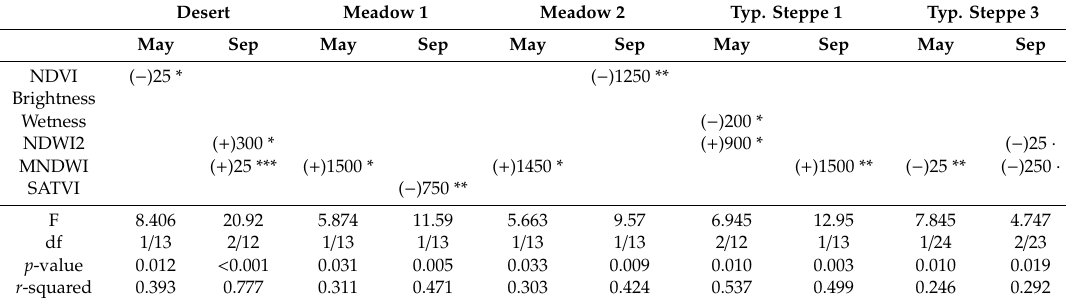
Table 3. Multiple linear regression models of carabid abundances with multispectral indices after excluding vegetation indices with collinearity problem and a stepwise procedure to select the best model on the remaining vegetation indices (NDVI, tasseled-cap brightness, tasseled-cap wetness, NDWI2, MNDWI, and SATVI). Spatial scales (cardinal distances in meters representing circle radius ranging from 25 to 1500 m) at which the e ff ects of estimators of indices (( + ) for positive and ( − ) for negative)) explaining carabid abundance are significant. Models with tasseled-cap brightness were never better than the others; however, when this variable was considered alone, it was significant at some scales in Meadow 1 and Meadow 2. Desert Meadow 1 Meadow 2 Typ. Steppe 1 Typ. Steppe